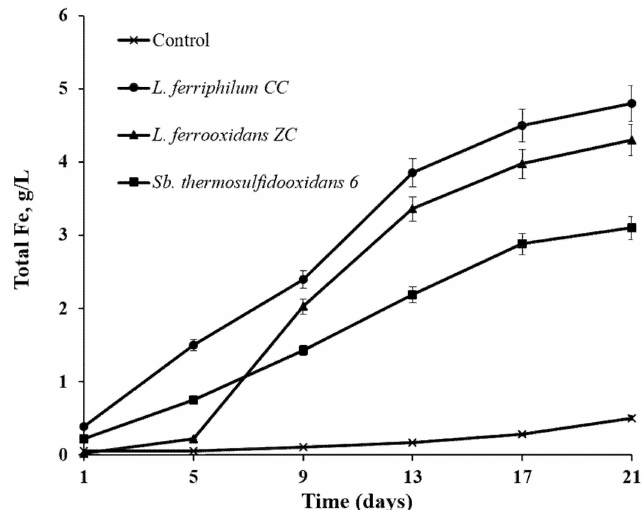
Figure 1. Bioleaching of pyrite (FeS 2 ) measured by the release of iron ions, in assays without bacteria (Control), with L. ferriphilum CC, L. ferrooxidans ZC, and Sb. thermosulfidooxidans 6 (FeS 2 —5%, pH = 2.0, T = 37 ◦ C, shaking—180